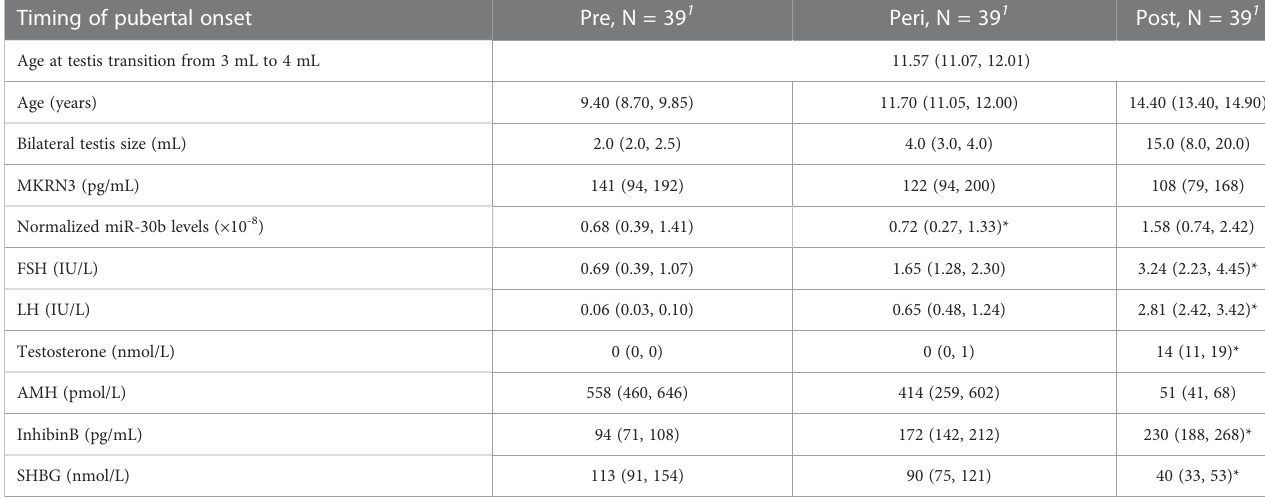
TABLE 1 Descriptive table of the main